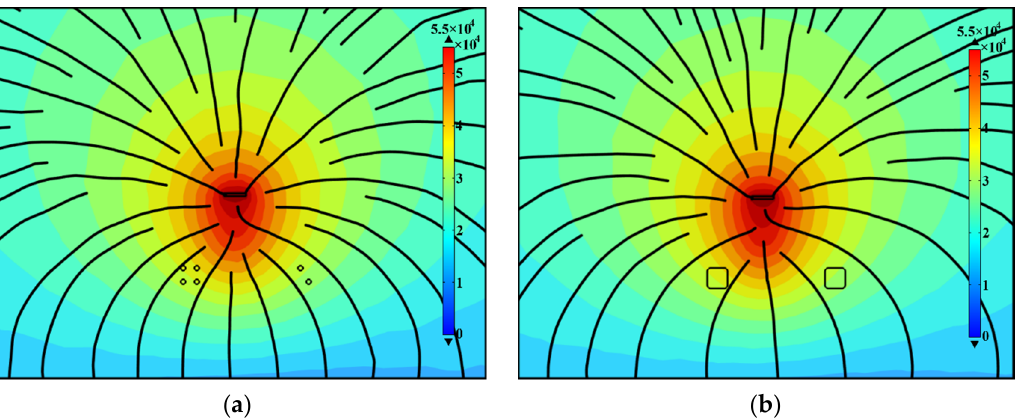
Figure 17. Cross-section of metallic plates attached to the end of the bolts: ( a ) initial state; ( b ) after the bolts were covered with metal plates.